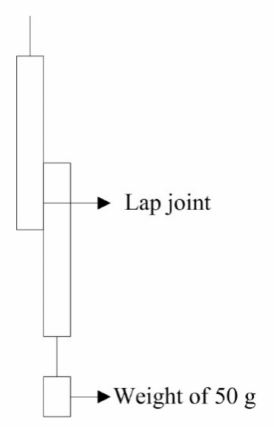
Figure 3. Schematic diagram of the temperature resistance